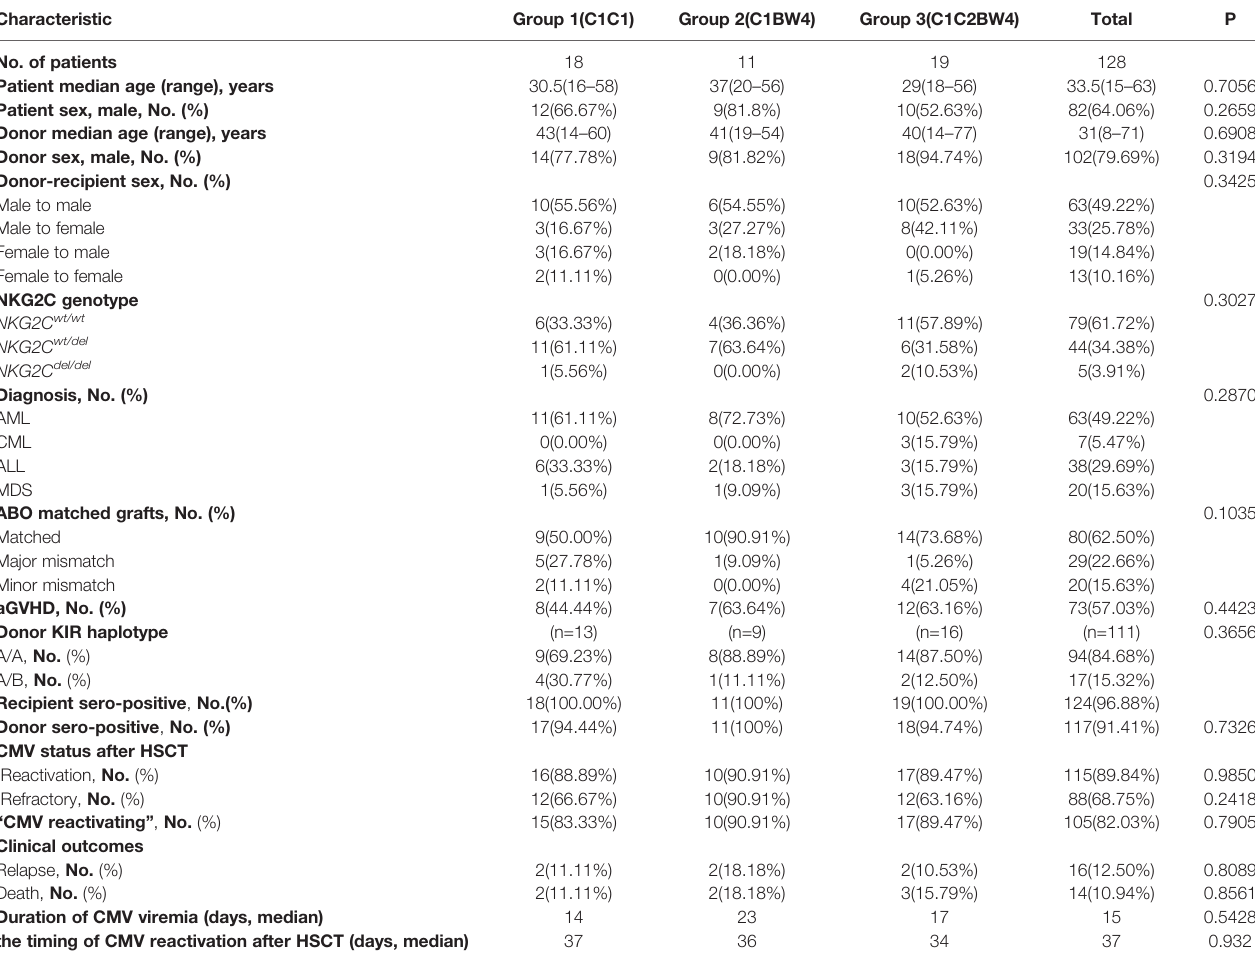
TABLE 1 | Patient